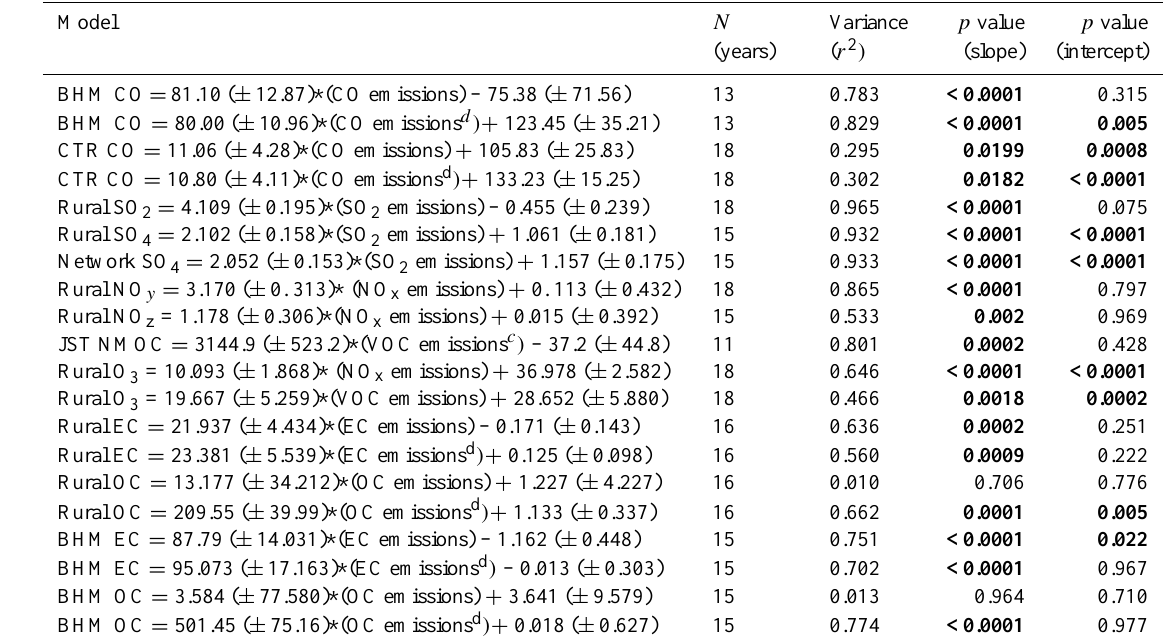
Table 1. Linear regression trends models relating 1996–2013 annual average ambient concentrations (ppbv for CO, NO y , NO z , NMOC, and O 3 ; µgm − 3 for SO 2 , SO 4 , EC, OC) to annual, regional a chemical emissions (MMTyr − 1 ). Statistically significant ( p < 0 . 05) results are indicated by bold-face p values b